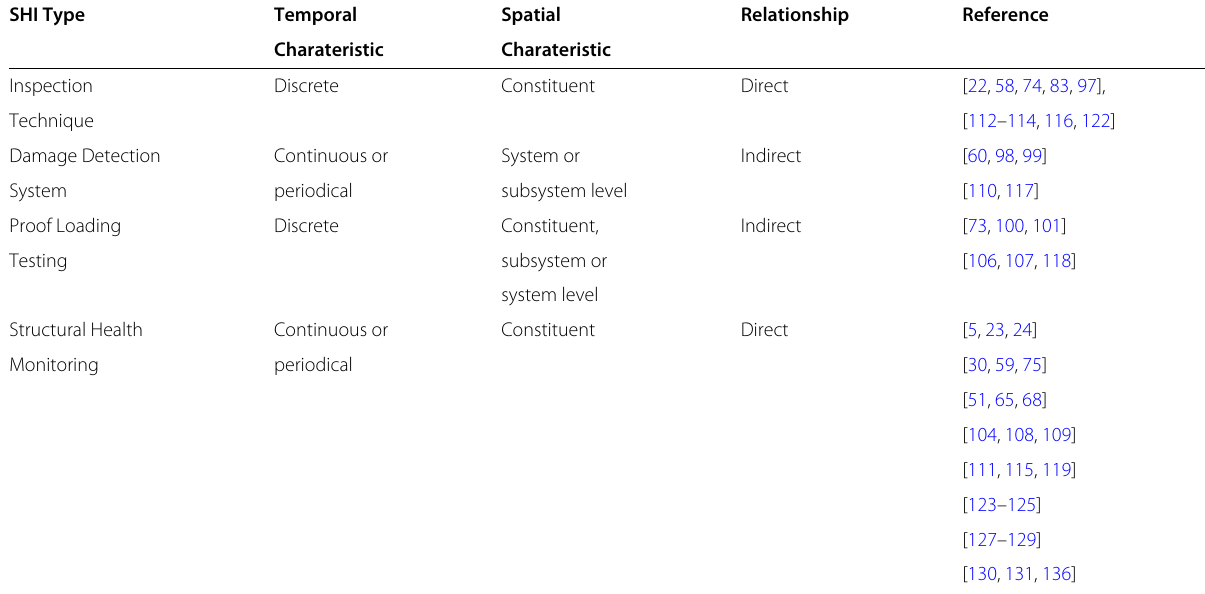
Table 2 SHI types example